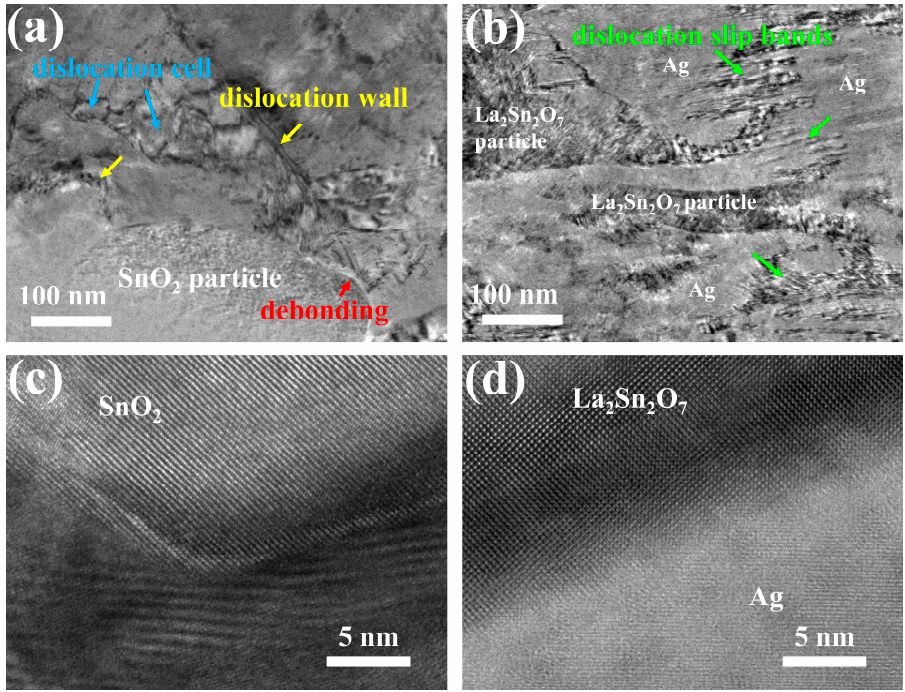
Figure 2. TEM images of Ag − SnO 2 ( a , c ) and Ag − La 2 Sn 2 O 7 ( b , d